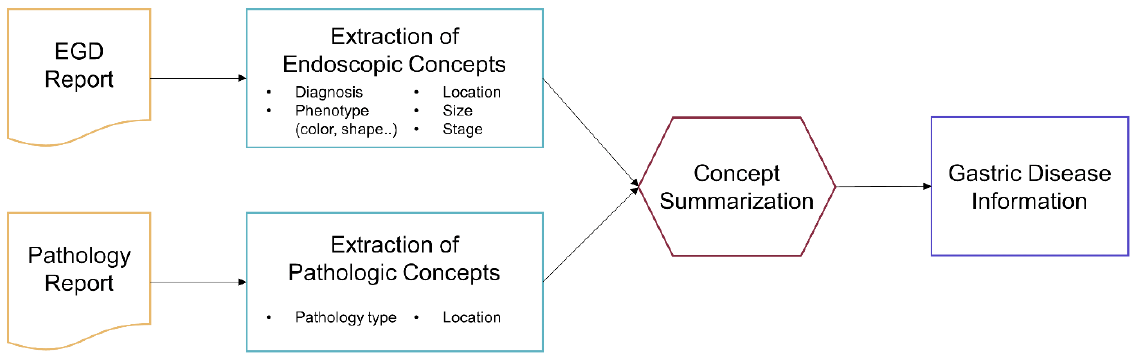
Figure 2. Process of information extraction using the NLP pipeline from EGD and pathology reports. NLP: natural language processing; EGD: esophagogastroduodenoscopy.